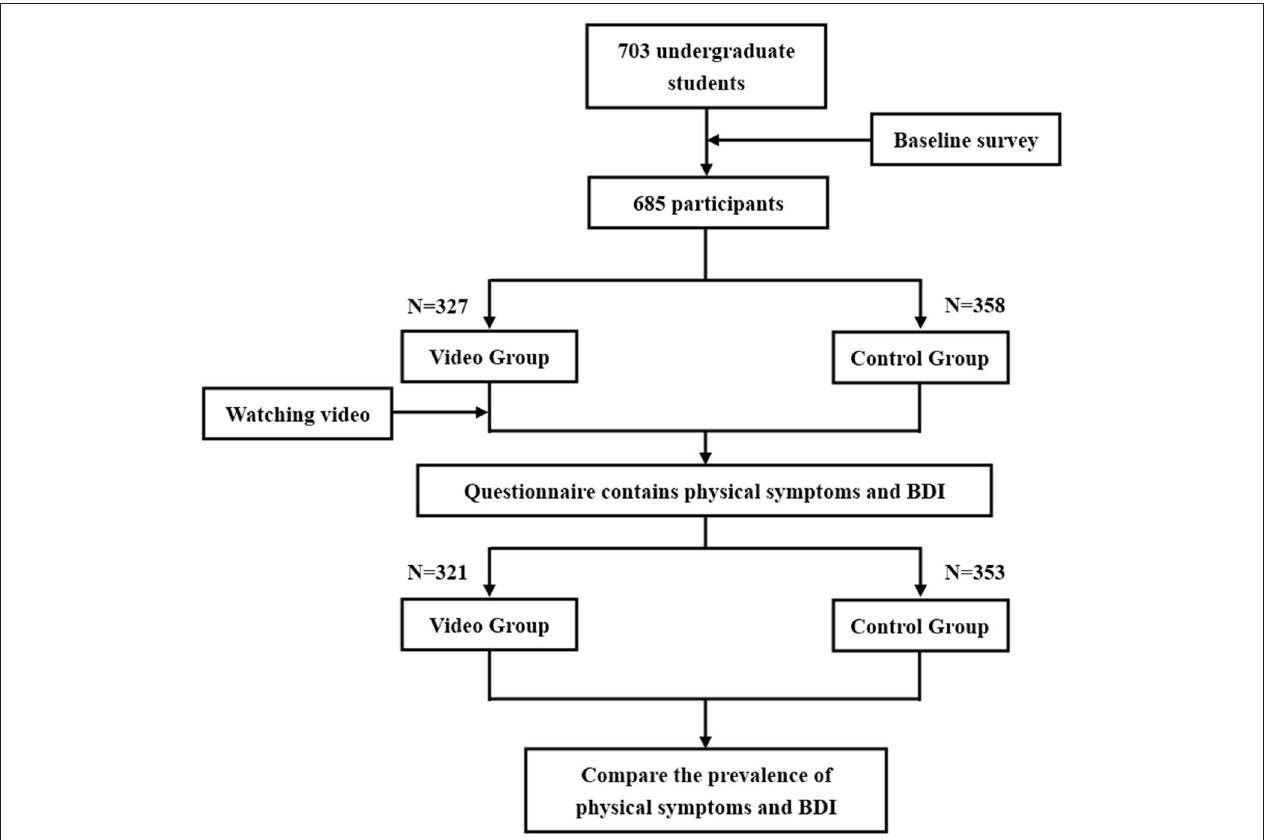
FIGURE 1 | Flow diagram of trial